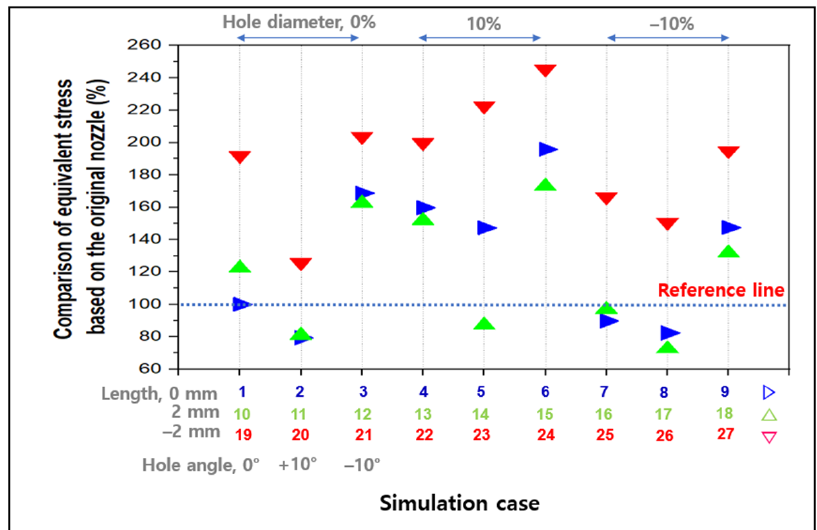
Figure 12. Comparison of equivalent stress based on the original nozzle. The equivalent stress is inversely proportional to the variable of the hole pipe